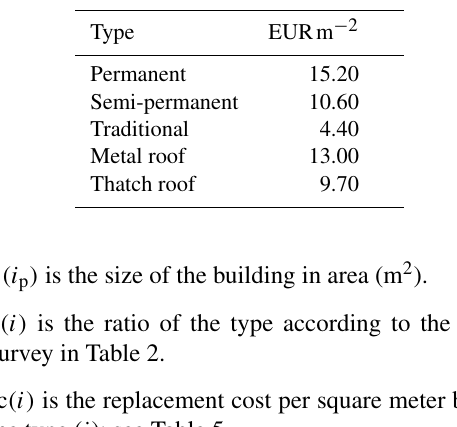
Table 5. Estimated maximum damage values per square meter based on local knowledge of replacement costs (Teule et al.,